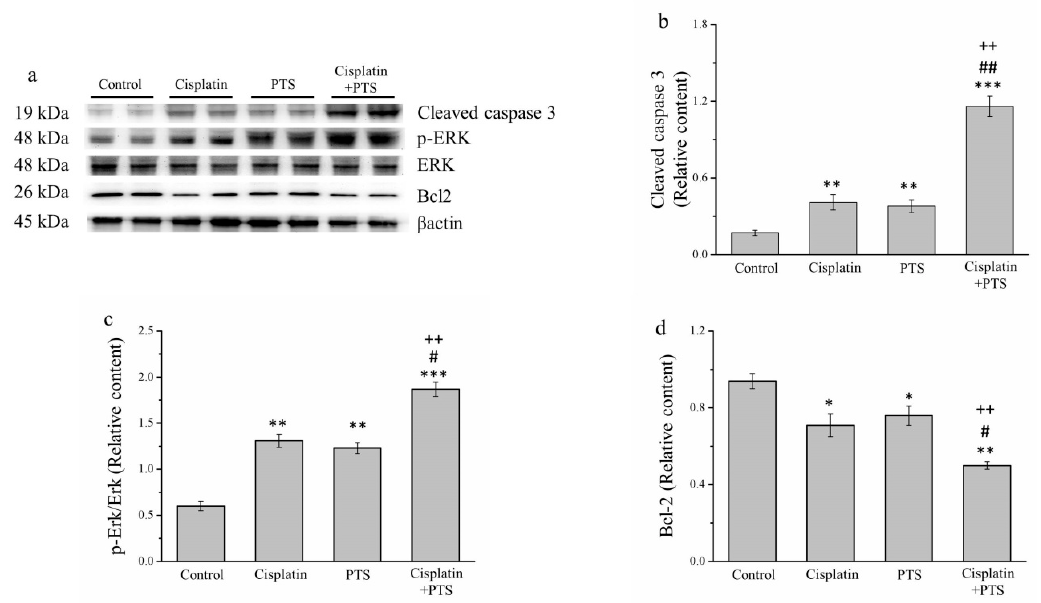
Figure 3. Western blot analysis of apoptosis-related proteins in M5 canine melanoma tumors im- planted in BALB/c nude mice. ( a ) Representative Western blot. ( b – d ) Quantitative comparisons of the expression of cleaved caspase 3 ( b ), phosphorylated ERK ( c ), and ( d ) Bcl-2. The mice were ad- ministered the following treatments three times per week: saline (control), 2 mg/kg cisplatin (cispla- tin), 100 mg/kg PTS (PTS), or 100 mg/kg PTS and 2 mg/kg cisplatin (cisplatin + PTS). Data are pre- sented as mean ± SD, n = 7 per group. * p < 0.05, ** p < 0.01, and *** p < 0.001 vs. control; # p < 0.05 and ## p < 0.01 vs. cisplatin; ++ p < 0.01 vs. PTS.